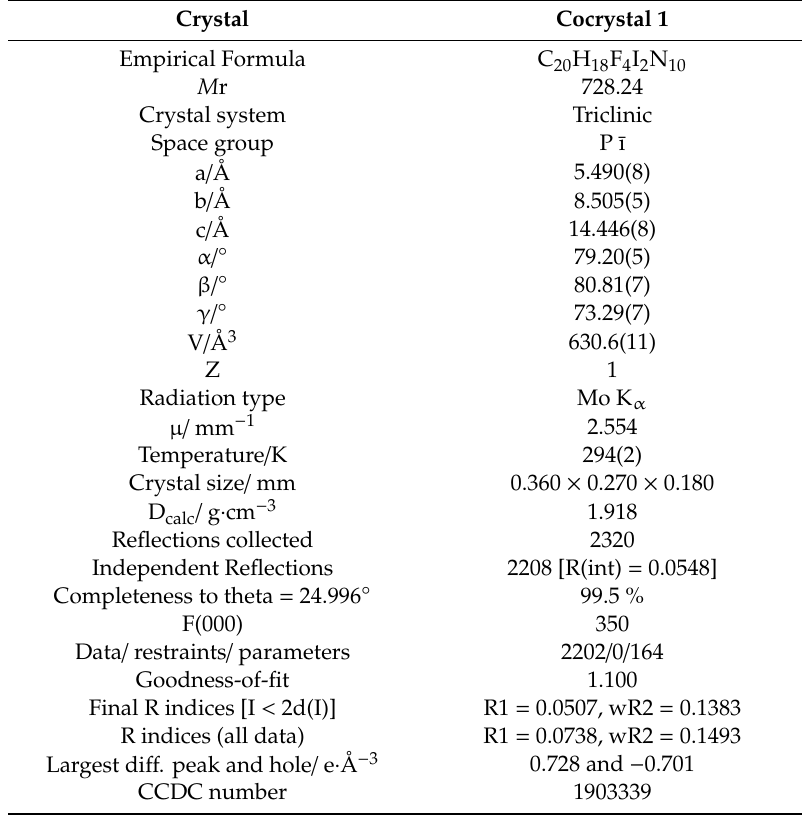
Table 1. Crystallographic data and refinement for cocrystal 1